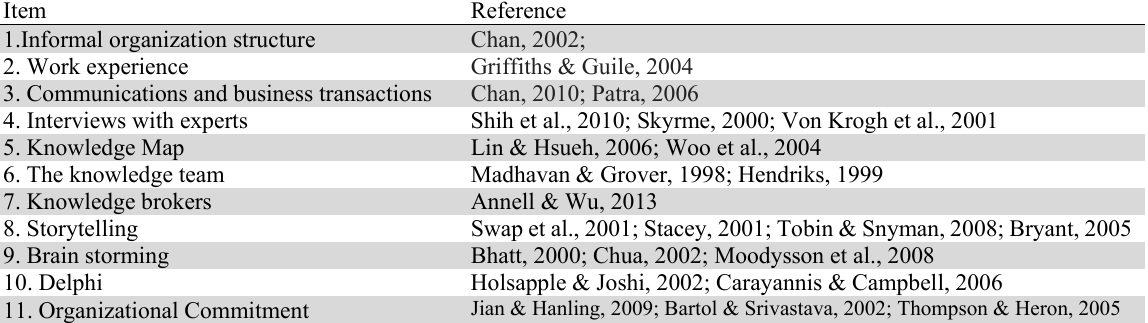
Sources of information creation